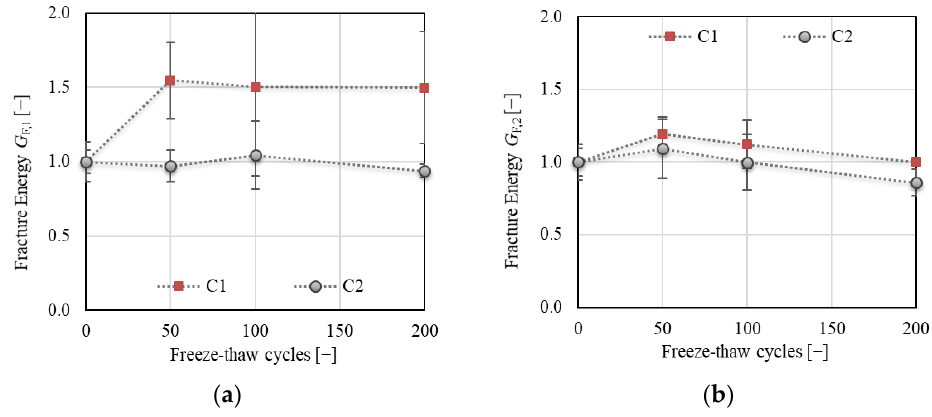
Figure 12. ( a ) Fracture energy G F,1 (up to the peak load); ( b ) fracture energy G F,2 (post-peak part).